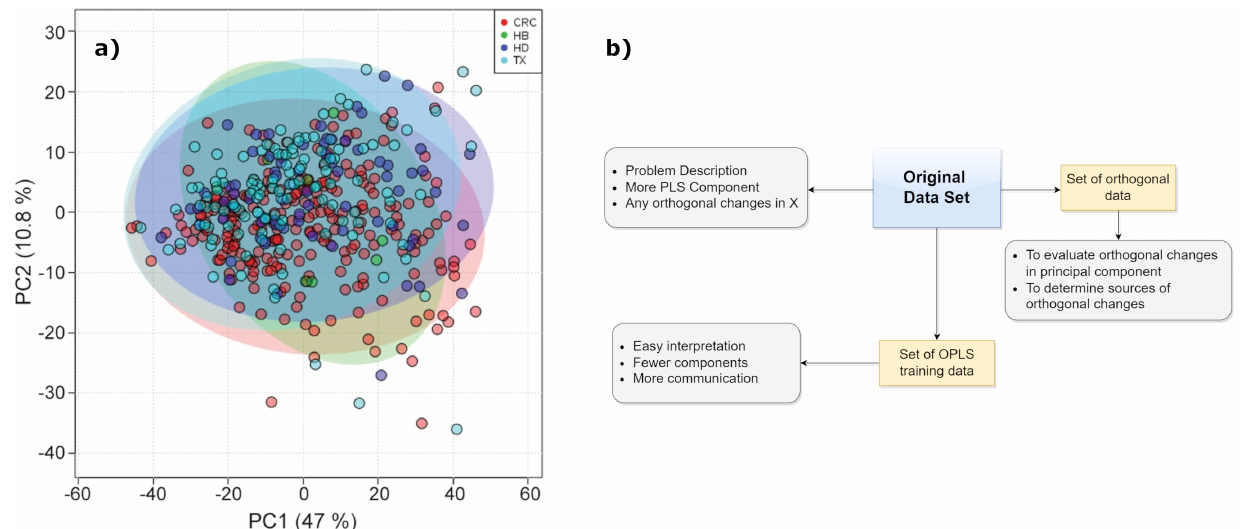
Figure 8. ( a ) Bidimensional PLS-DA score plot of urine samples obtained from different hospitals. Figure reprinted from [67] under the terms of Creative Commons Attribution 4.0 International License. ( b ) OPLS